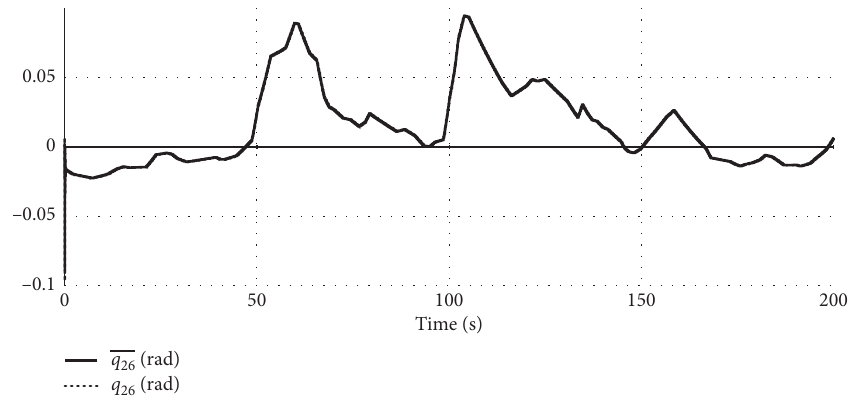
Figure 24: Full-time simulation of the slow variable q